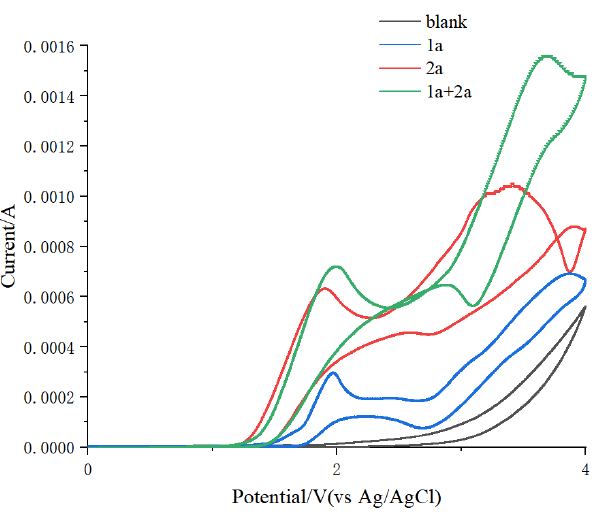
Figure 2. Cyclic voltammograms of substrates.